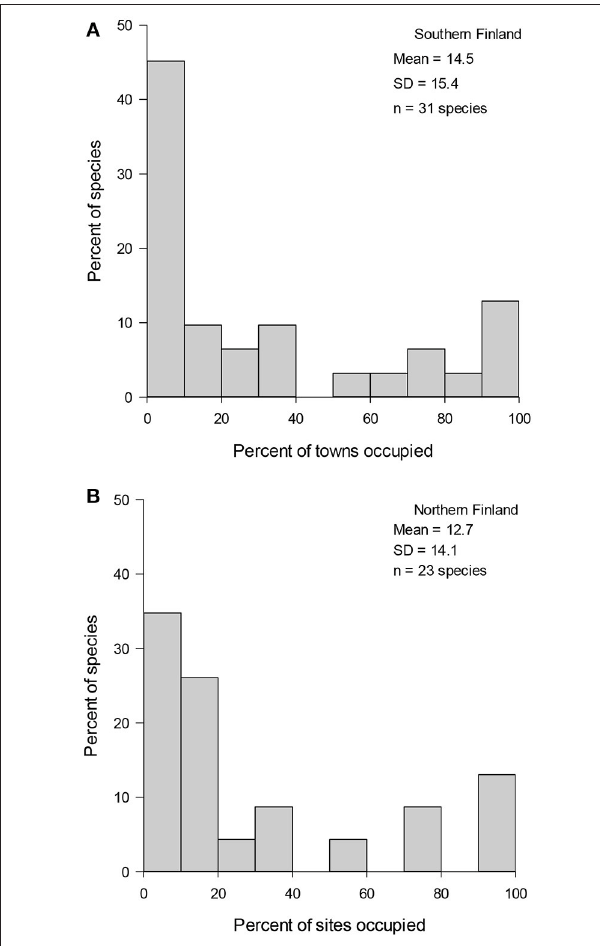
FIGURE 4 | Variation in urban wintering bird species relative occupancy frequency distributions in (A) southern ( n = 15 towns) and (B) northern towns ( n = 14 towns). Mean number of sites occupied and standard deviation (SD) of regional occupancy as well as the number of species ( n ) detected during three winters in Finland.